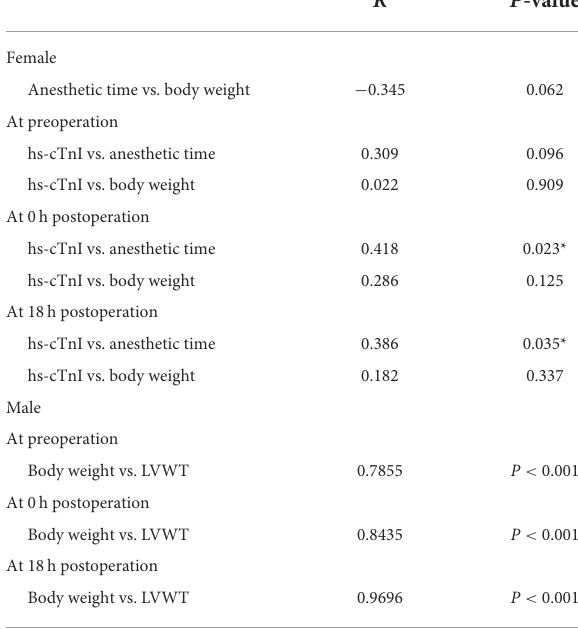
TABLE 4 Correlation coefficients for hs-cTnI, ANP, HR, SAP, and LVWT in all cats. All cats from